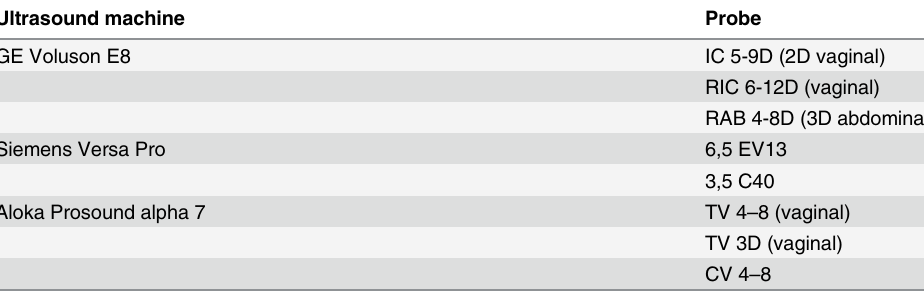
Table 1. Investigated ultrasound machines and vaginal/ abdominal probes. Ultrasound